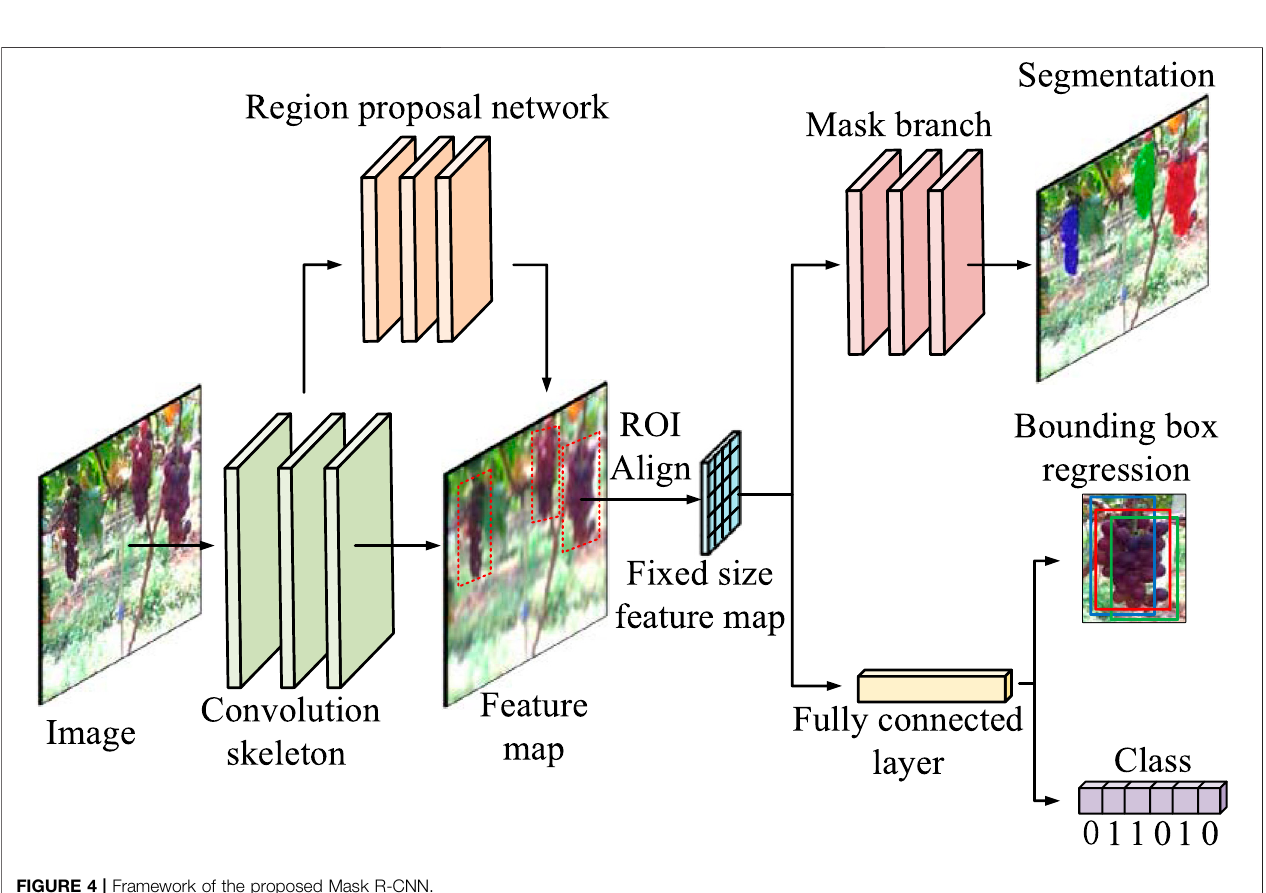
FIGURE 4 | Framework of the proposed Mask